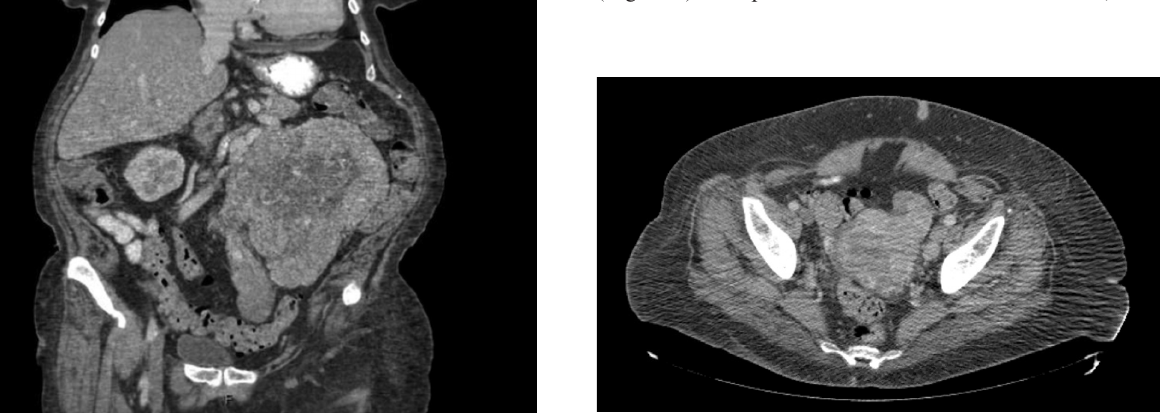
Figure 1: Coronal view of computed tomography of abdo- men/pelvis revealing a large left renal mass with direct exten- sion into the left gonadal vein.